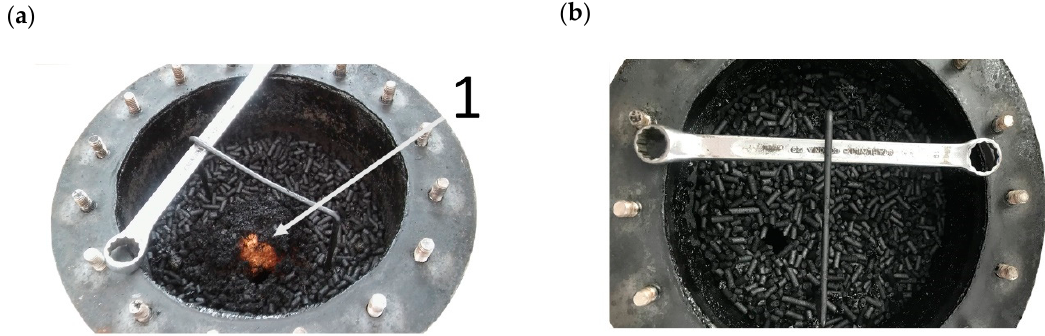
Figure 12. Torrefied pellet at ( a ) atmospheric pressure, ( b ) over atmospheric pressure. 1—pellet that was partially disintegrated and not fully torrefied during the ap process.